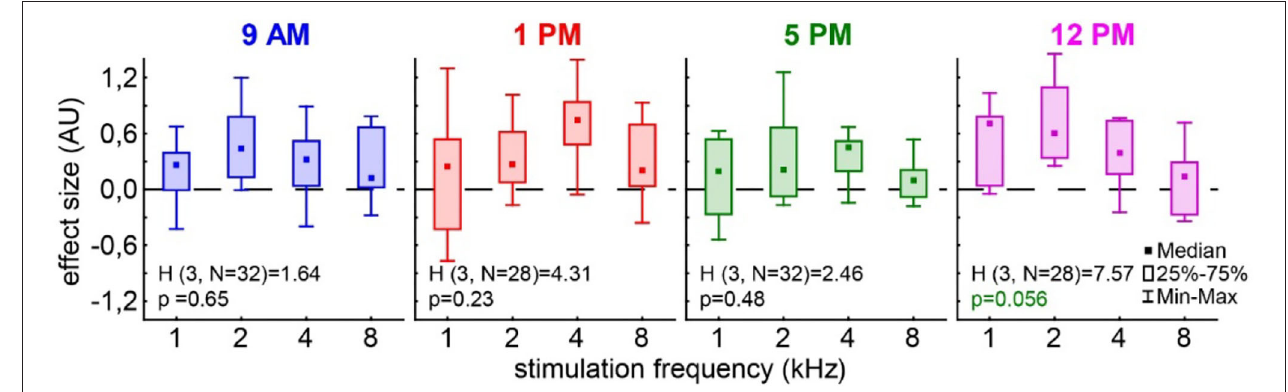
FIGURE 3 | Effect size of the PPI change post vs. pre-trauma. The Kruskal–Wallis ANOVAs (H-statistics) were calculated independently for each trauma time group. Boxes depict the interquartile range, and whiskers give the range of the complete distribution.